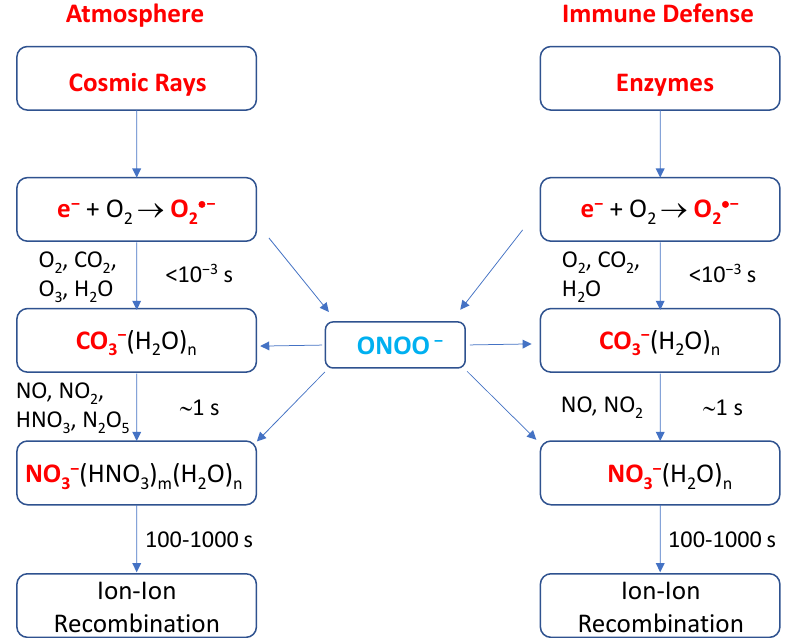
Figure 3. Schematic representations of the negative ion chemistry in the undisturbed stratosphere and troposphere of the Earth [61,62] and in the phagolysosome in the innate immune defense system in humans.